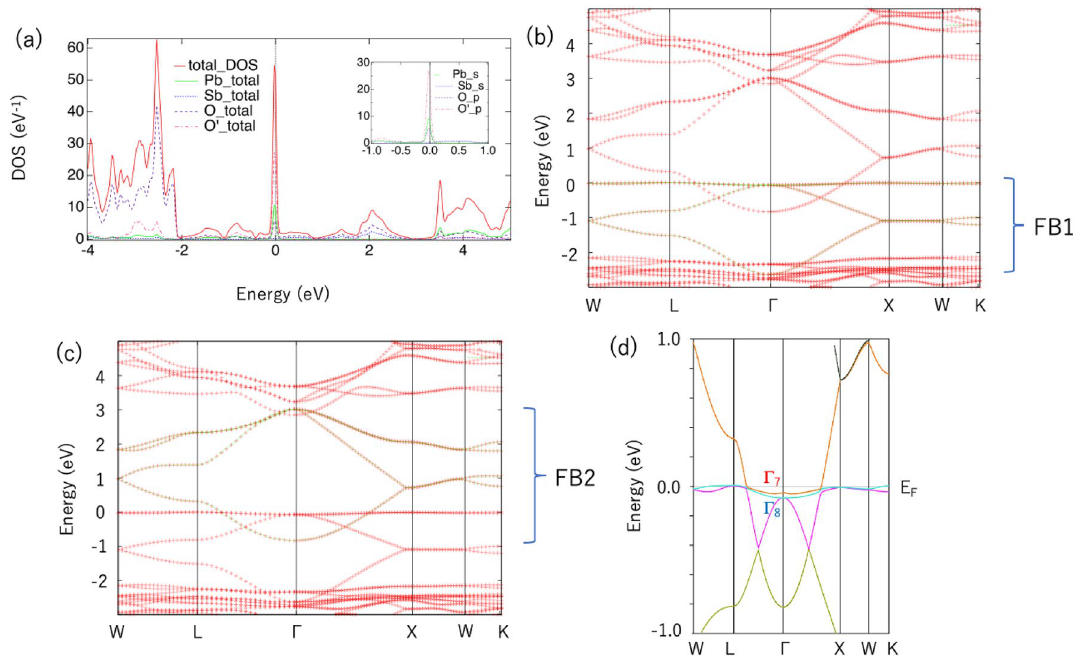
Figure 1. ( a ) DOS curve of Pb 2 Sb 2 O 7 from first-principles calculations. The inset shows a zoomed-in view of the DOS, including the Pb- s , Sb- s , O- p , and O ′ - p components. ( b ) Energy dispersion of Pb 2 Sb 2 O 7 . Red points are obtained from our first-principles calculations, and green points (FB1) are obtained from maximally localized Wannier function (MLWF) fitting with four “Pb- s ” orbitals. ( c ) Red points are the same as in ( b ), and green points (FB2) are obtained by MLWF fitting with four “Sb- s ” orbitals. ( d ) Energy dispersion of Pb 2 Sb 2 O 7 near E F , including spin-orbit interaction. E F is set to 0 eV or the VBM. The parameters used in ( b,c ) are listed